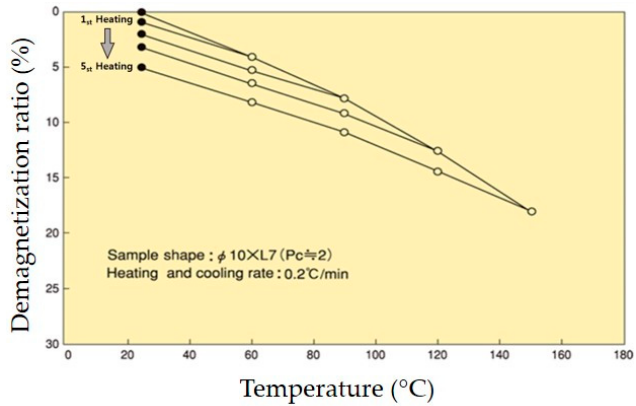
Figure 6. Demagnetization ratio curves of the test SPMSM with respect to temperature variations.